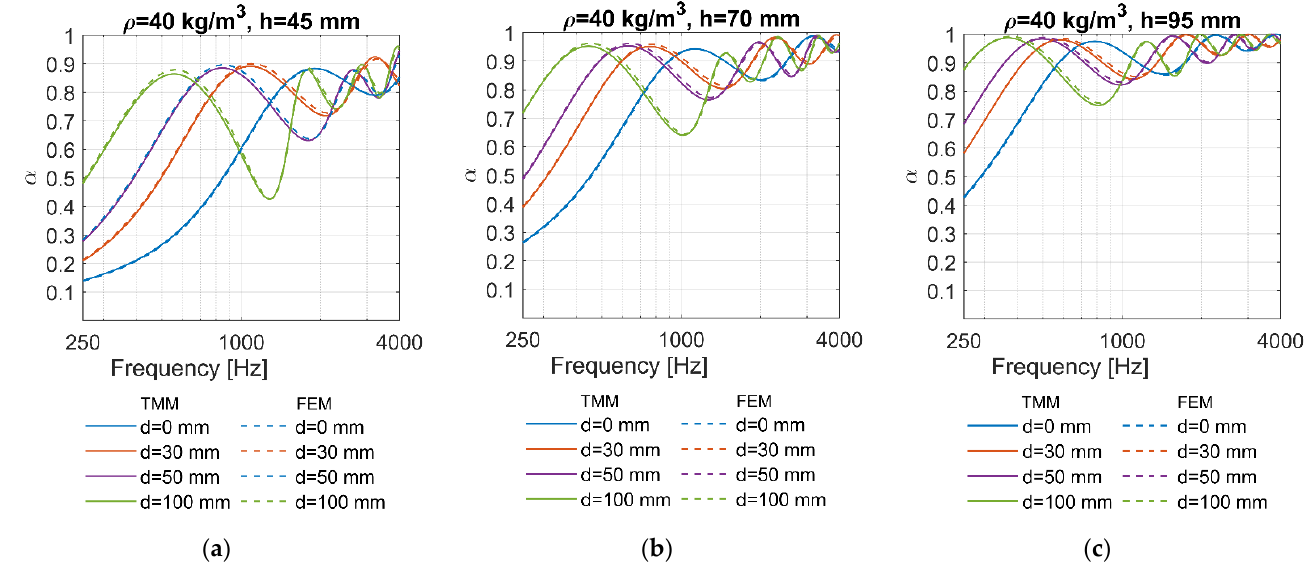
Figure 12. Sound absorption coefficients for different air gap thicknesses, ρ = 40 kg/m 3 .